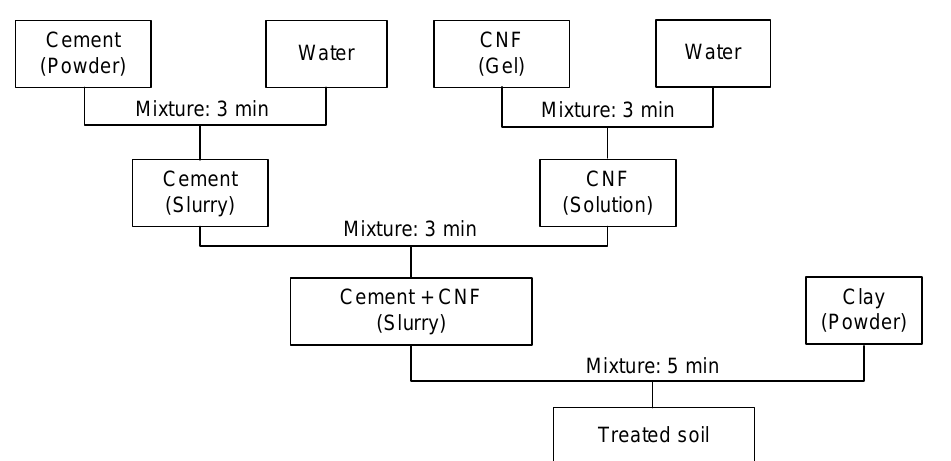
Figure 1. Mixture procedure for preparing specimens (Method 1).